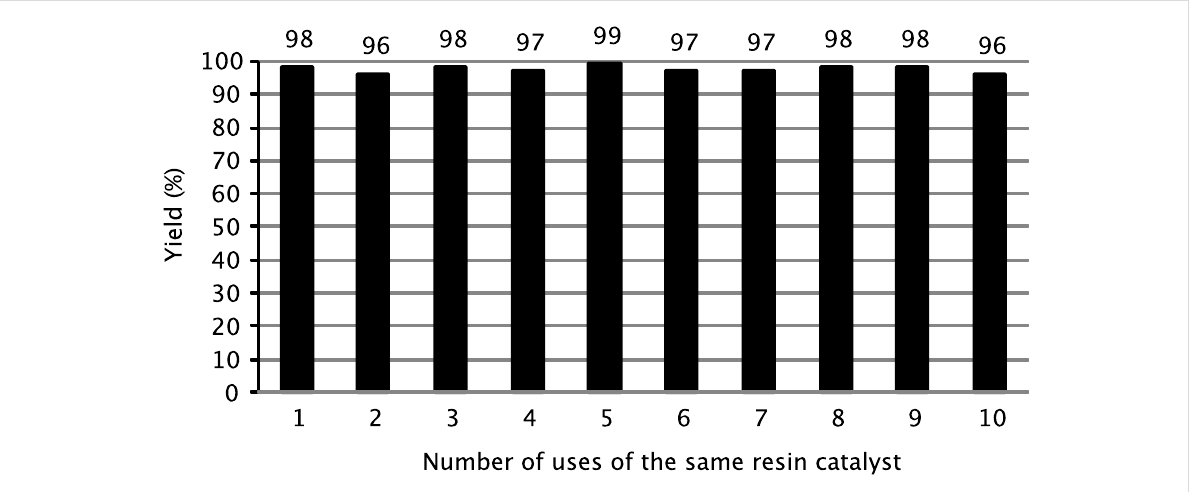
Figure 1: Recycling of the ion-exchange-resin catalyst in the adamantylation reaction of 4-bromophenol ( 1a ) with 1-adamantanol ( 2a